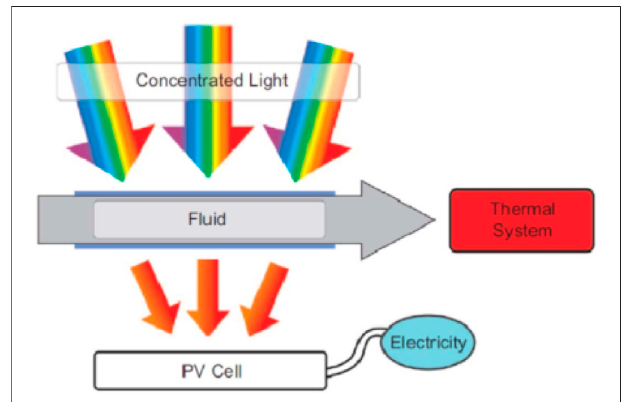
FIGURE 6 | Sketch of the de-coupled PV/T system concept (Taylor et al.,